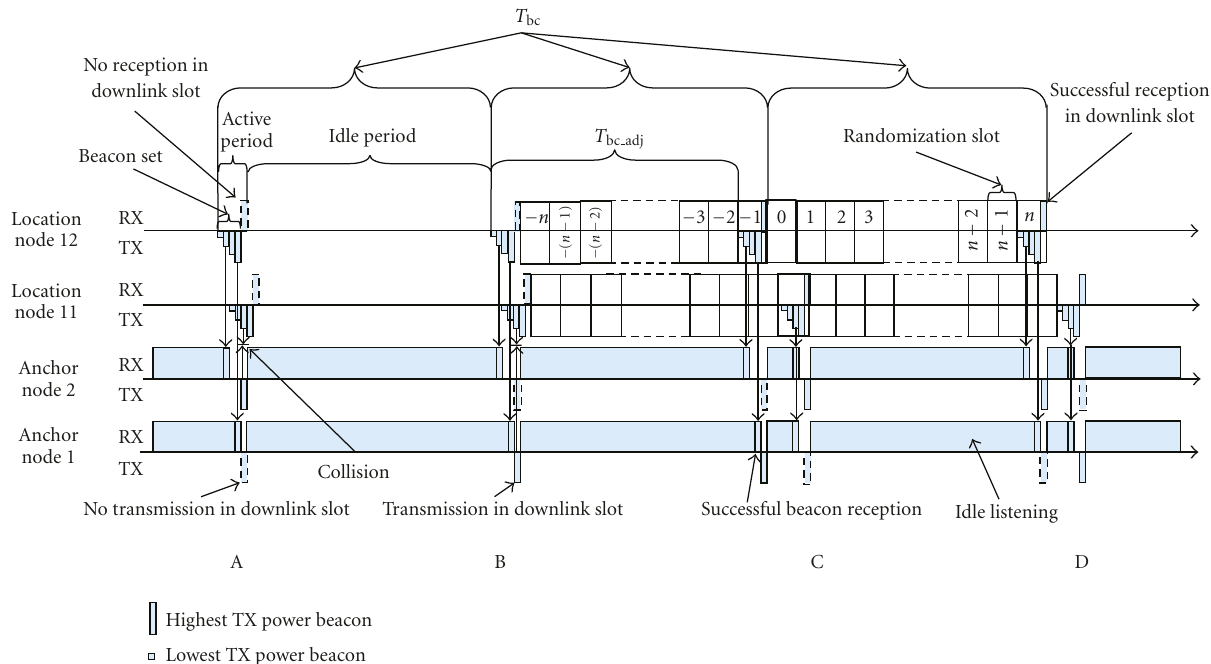
Figure 3: LocMAC base operation principle: LocMAC beacon cycle components, collision avoidance, and